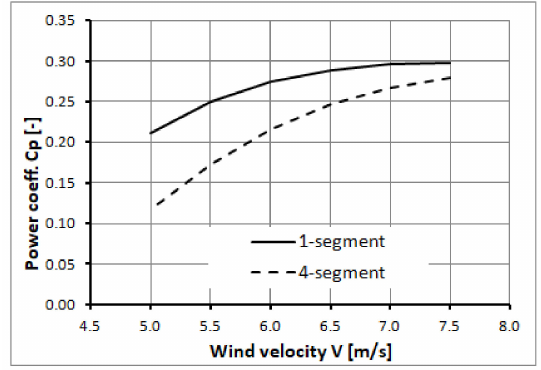
Figure 15. Maximum effectiveness (Cp) for both